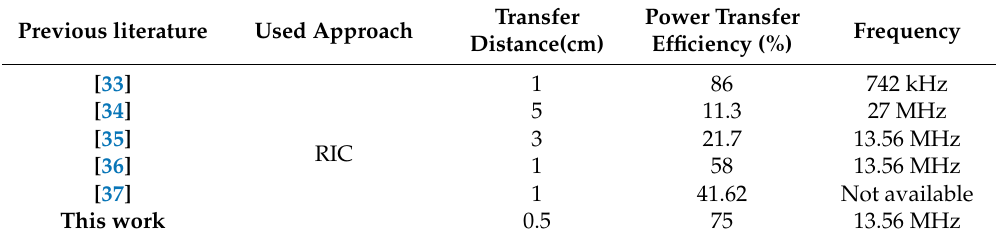
Table 9. Comparison between the previous literature and this